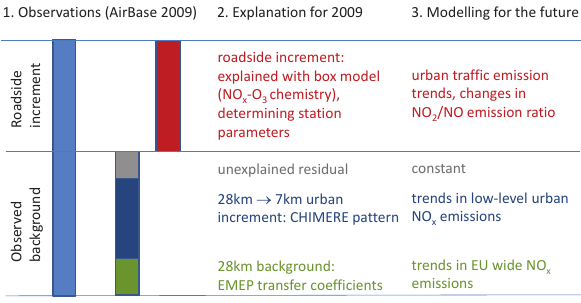
Fig. 1. Schematic overview of the traffic station scheme. Observed roadside concentrations (left) are first disaggregated into back- ground and traffic increment (step 1), then the different compo- nents are explained to the extent possible for 2009 (step 2). For the roadside increment, this involves estimating the station-specific parameters (residence time of air in the street canyon, background representativeness correction if needed). For the modelling of sce- nario years other than the base year (step 3), we consider changes in European-wide NO x emissions for the background, and changes in urban driving emissions (including changes in primary NO 2 emis- sions) for the traffic increment.